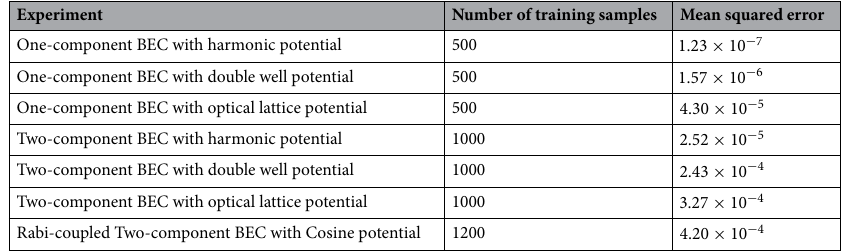
Table 1. Error estimates from